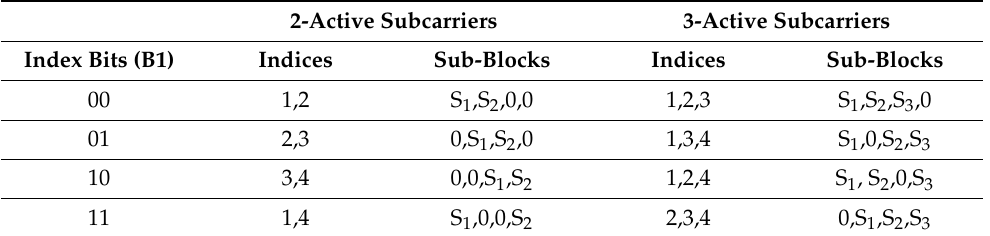
Table 1. Subcarrier selection for a 2-bit index data word on B1 using conventional SIM OFDM.